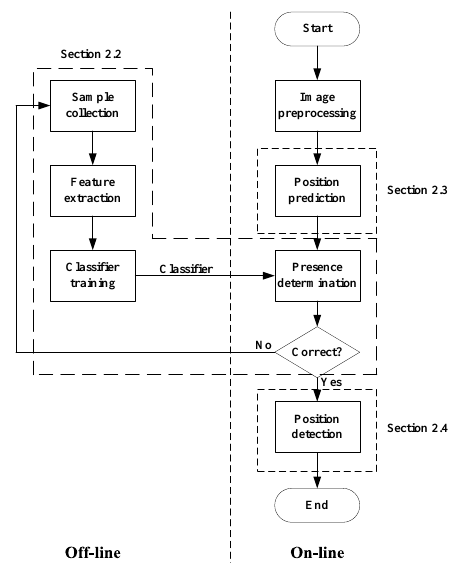
Figure 2. The process of polar body detection.